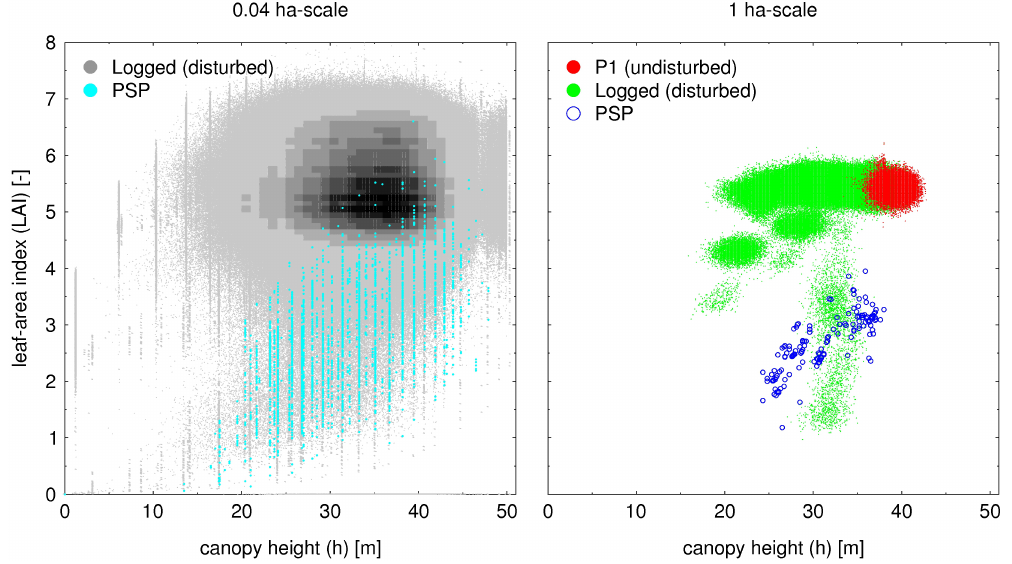
Fig. 6. Relation between leaf area index (LAI) and canopy height ( h ). on the (A) 0.04ha-scale and (B) 1ha-scale. Results for the undisturbed site P1, for disturbed forests all 24 logging scenarios, and for permanent sampling plot data (PSP). In sub-figure (A) only disturbed (logged) forests and PSP data are shown, because the scatter plot for the undisturbed forest (P1) is indistinguishable from the disturbed forest data. Due to the huge number of data points in the scatter plot of the 0.04ha-scale (more than 14000000) the grey-scale indicates the density of the data points with highest densities in black.